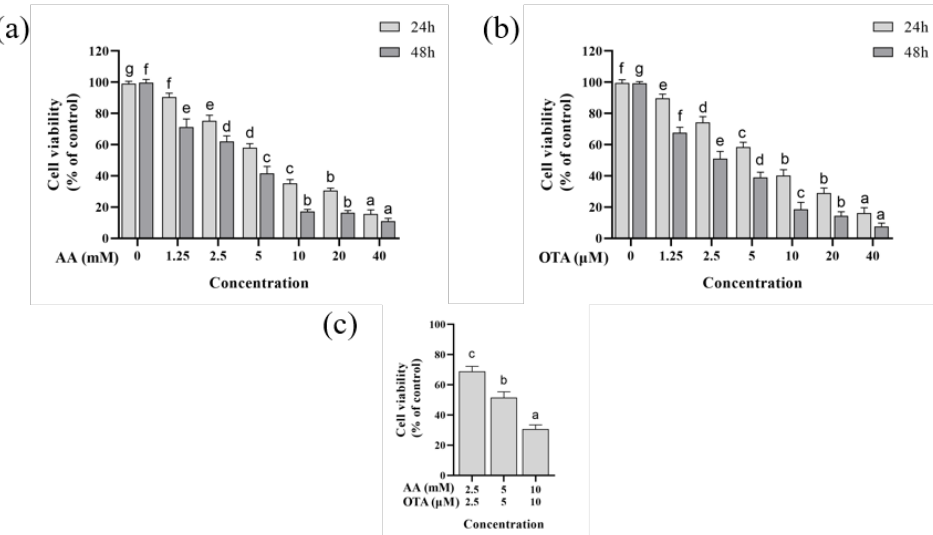
Figure 1. Effect of AA and OTA at different concentrations on the cell viability in Caco-2 cells. ( a ) Cell viability after 24 h or 48 h treatment with AA (0–40 mM). ( b ) Cell viability after 24 h or 48 h treatment with OTA (0–40 µ M). ( c ) Cell viability of Caco-2 cells exposed to mixtures of AA and OTA for 24 h. a–g Different letters indicate significant differences, p <